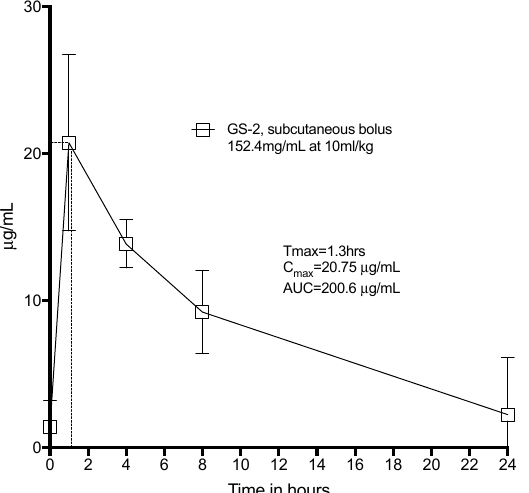
Figure 4. Toxicokinetics of GS-2 in Sprague-Dawley rats. Eight Sprague-Dawley rats were given a subcutaneous bolus dose of GS-2 at 10 mL/kg under the skin between the shoulder blades. Tail vein blood was drawn, processed, and assayed for capric acid at 1 h, 4 h, 8 h, and 24 h. n = 8, mean ± SD.